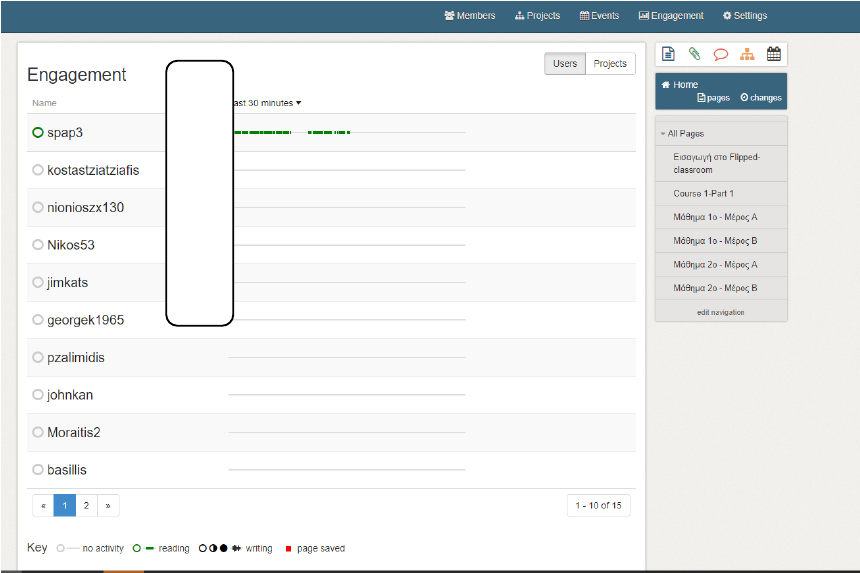
Fig. 2. The wiki environment providing 'Engagement' data for each